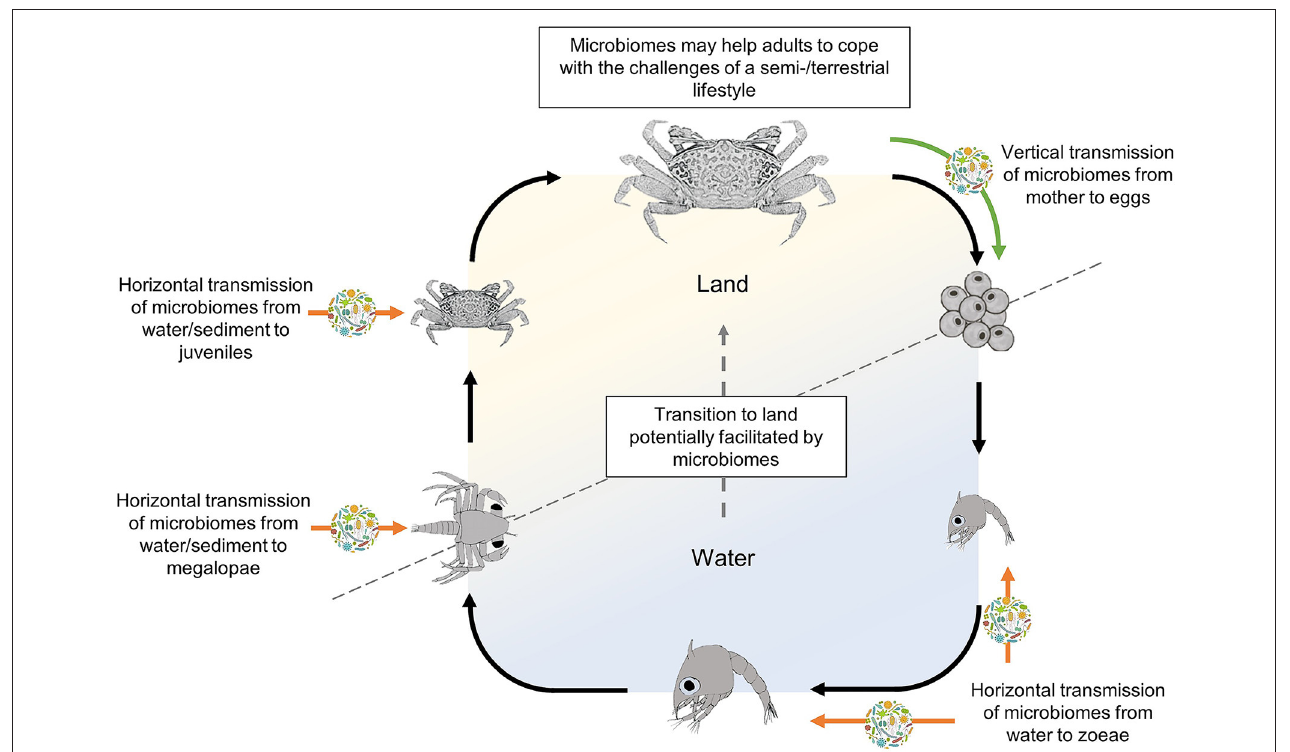
FIGURE 1 | Life cycle of a semi-terrestrial crab (here represented as a female fiddler crab; subfamily Gelasiminae, taken as a model species; adapted after Peer et al., 2015 ) indicating the potential time points of vertical and horizontal acquisition of symbiotic microbiomes that may facilitate the transition from a life in water to one on land. Green and orange arrows indicate potential vertical and horizontal transmission routes of symbiotic microorganisms, respectively. Black arrows indicate the model life cycle from egg, through larvae, to adult